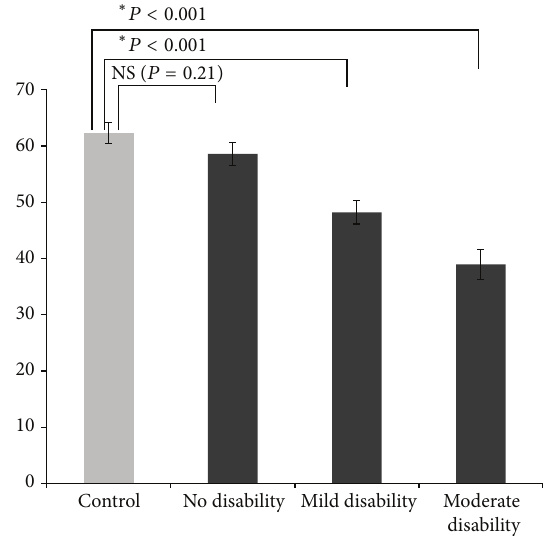
Figure 3: Mean SDMT scores for the control and three disability- stratified groups. ∗ Signifies that the difference between the control group and MS groups was statistically significant ( 𝑃 < 0.05